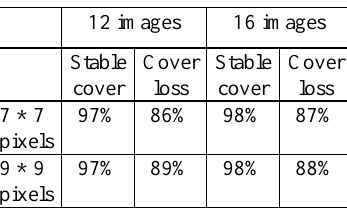
Table 2b . Accuracies of the models depending on patch sizes and pre-change data time series sizes.